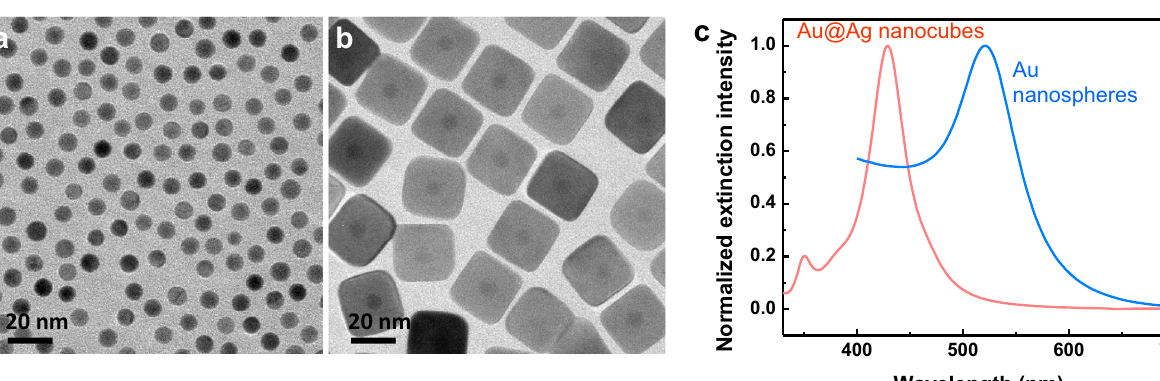
Figure 1. Schematic illustrating the concept of using Au@Ag nanocubes for the detection of H 2 O 2 .